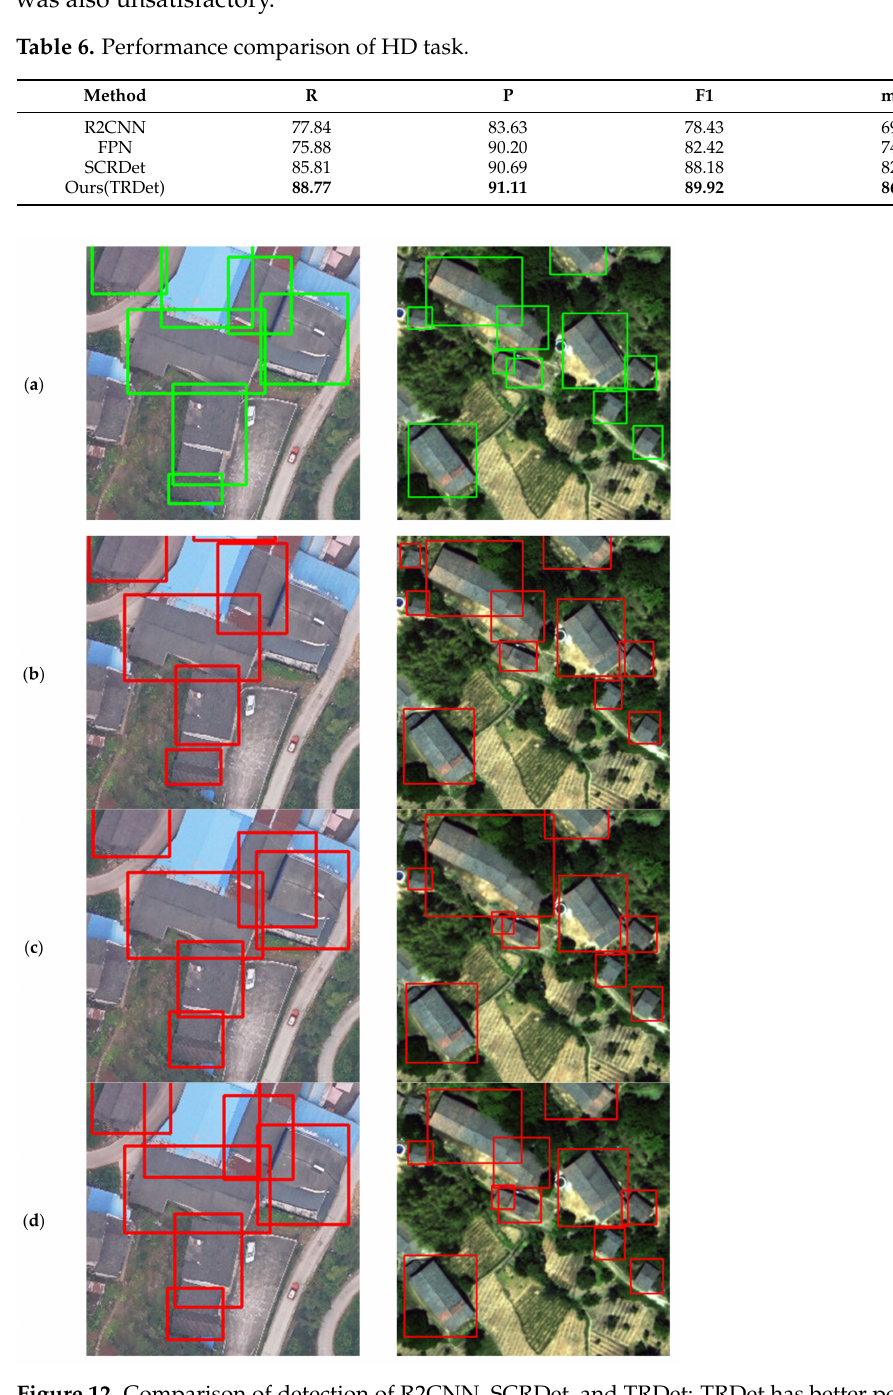
Figure 12. Comparison of detection of R2CNN, SCRDet, and TRDet: TRDet has better performance in the horizontal detection task. ( a ) the ground truth; ( b ) the R2CNN detection results; ( c ) SCRDet detection results; ( d ) TRDet detection